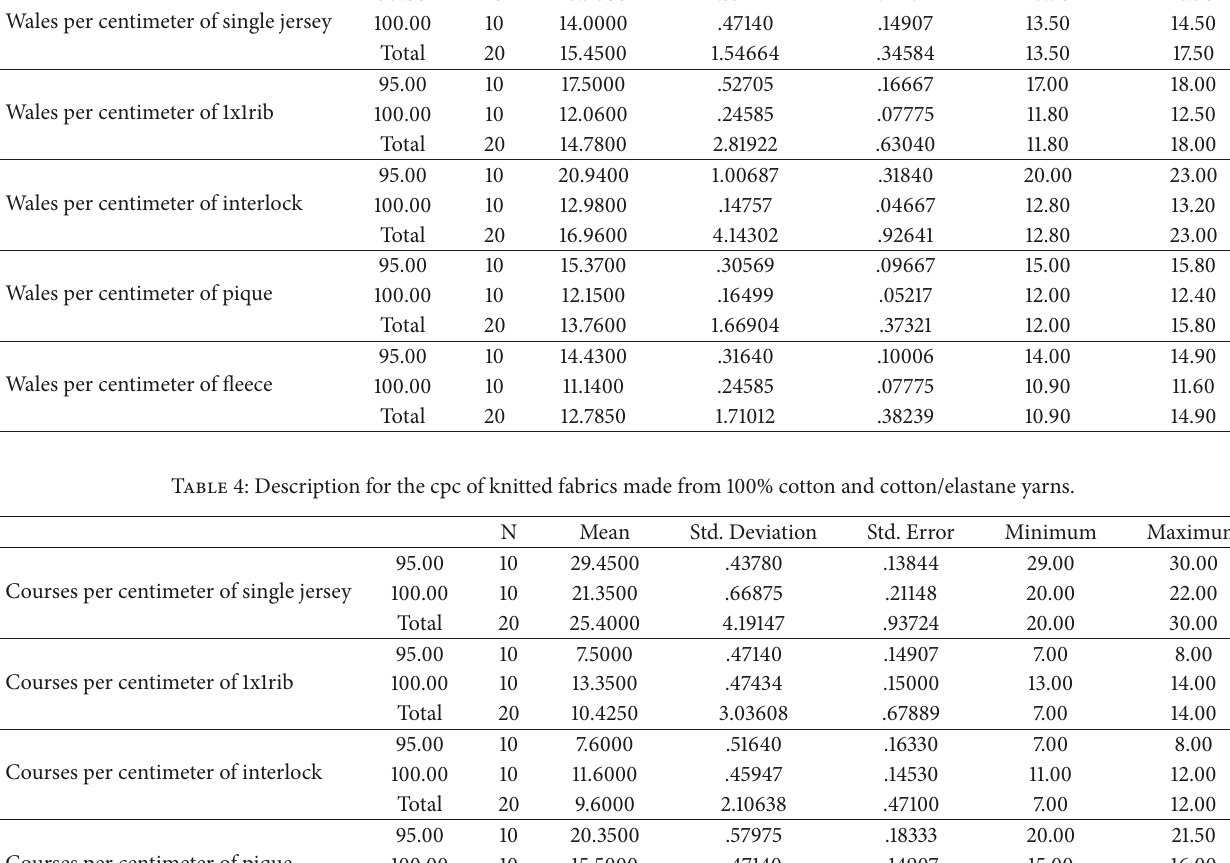
Table 3: Description for wpc of knitted fabrics made from 100% cotton and cotton/elastane yarns. N Mean Std. Deviation Std. Error Minimum